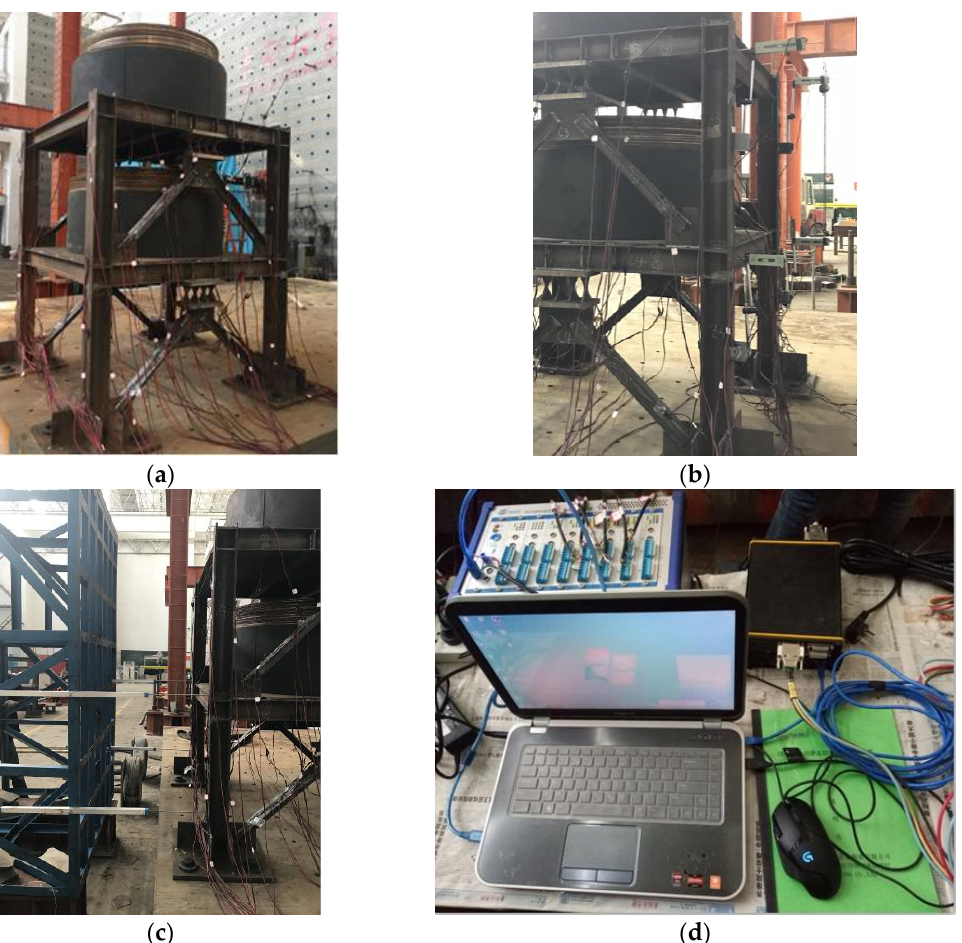
Figure 12. Measuring devices of the specimen. ( a ) Connection of strain gauges; ( b ) YHD sensors; ( c ) TST sensors; ( d ) data acquisition instrument.